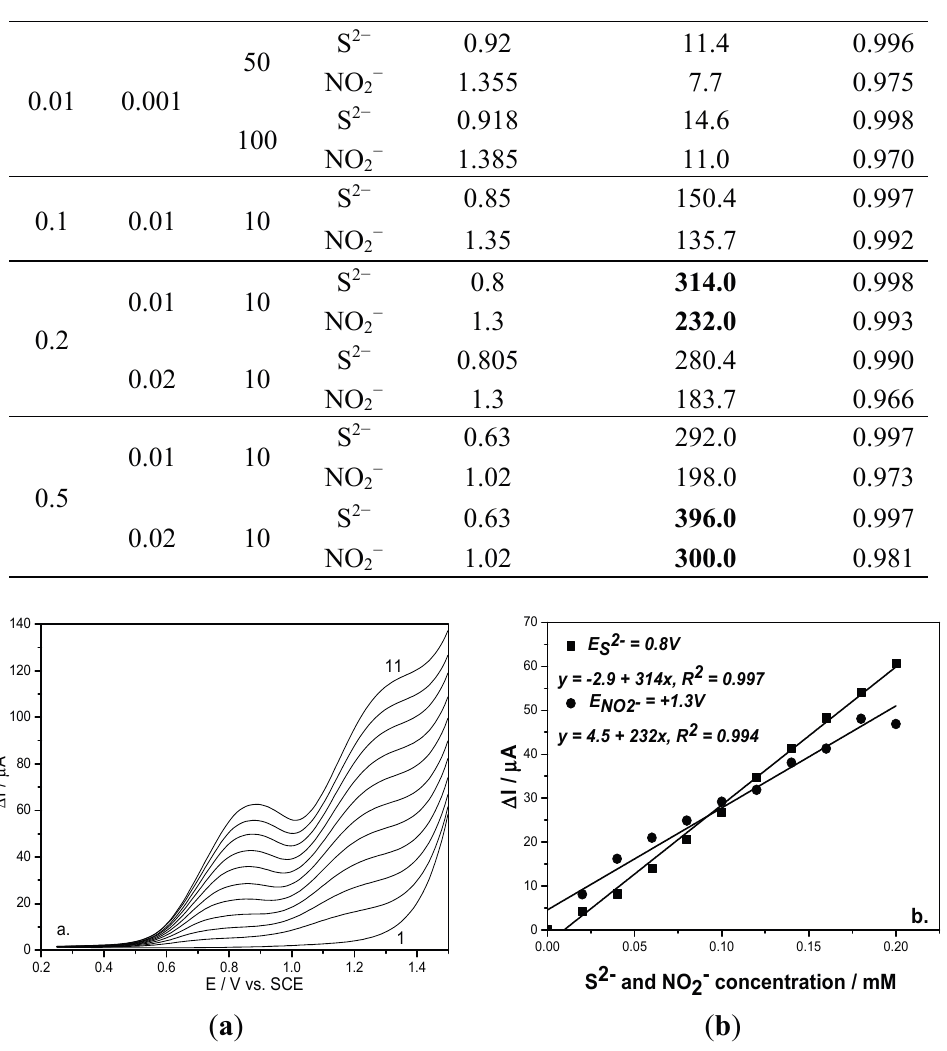
Table 1. Operating conditions for SWV and electroanalytical performance recorded at BDD electrode for simultaneous detection of sulfide and nitrite.